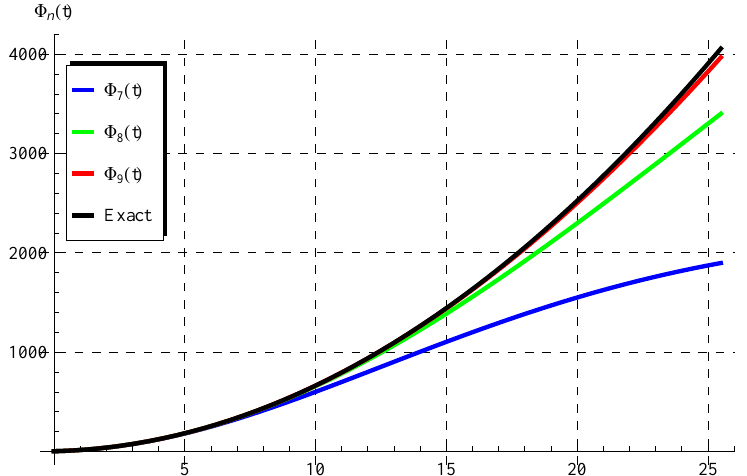
Figure 3. Comparisons between the approximate solutions Φ n ( t ) , n = 7,8,9 in Equation (67) and the exact solution in Equation (69) at a = − 2, b = 8, c = 1/2.